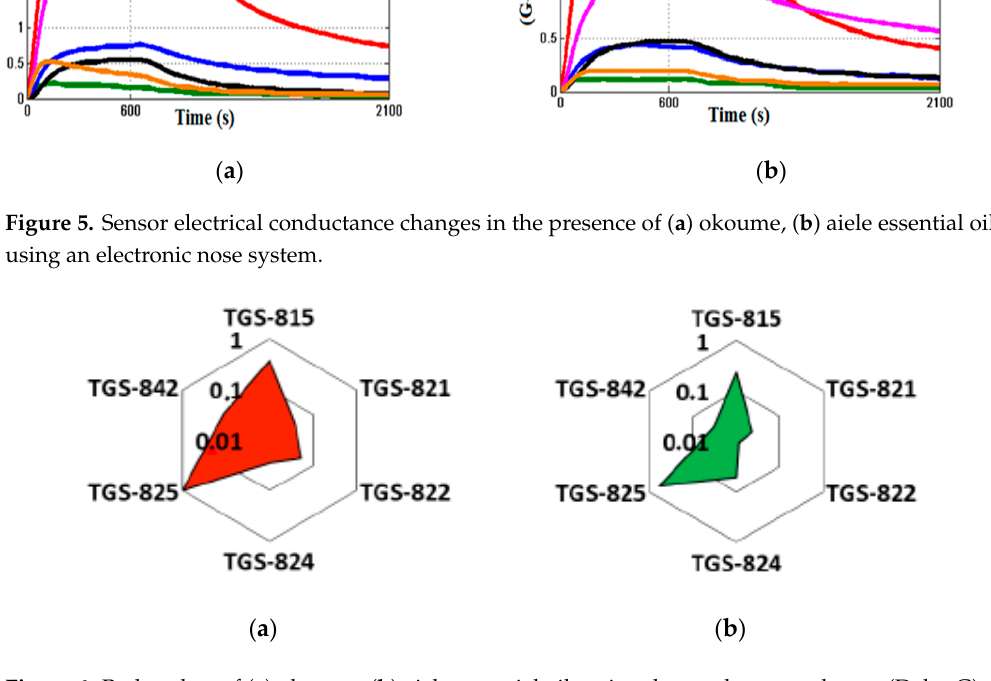
Figure 6. Radar plots of ( a ) okoume, ( b ) aiele essential oils using the conductance change (Delta-G) of sensors as response